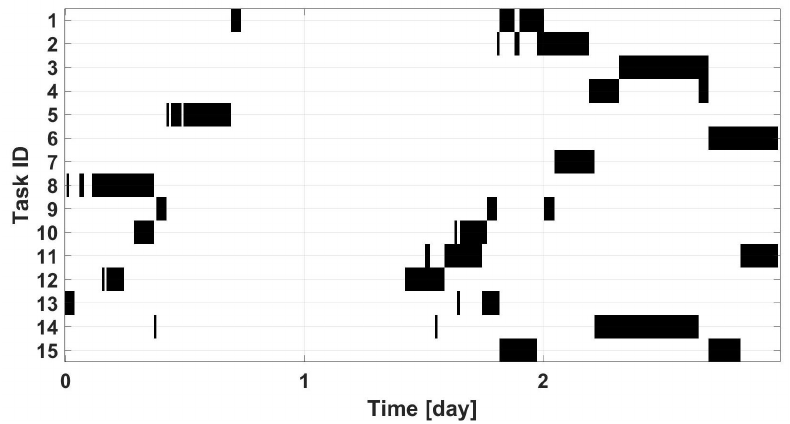
Figure 7. Task Planning Simulation